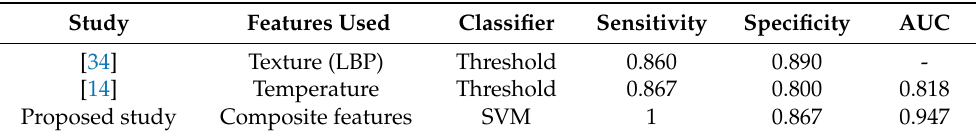
Figure 8. Diagnostic performance comparison of SVM, k-NN and LDA for facial paralysis. Table 11. Comparison between proposed method and existing